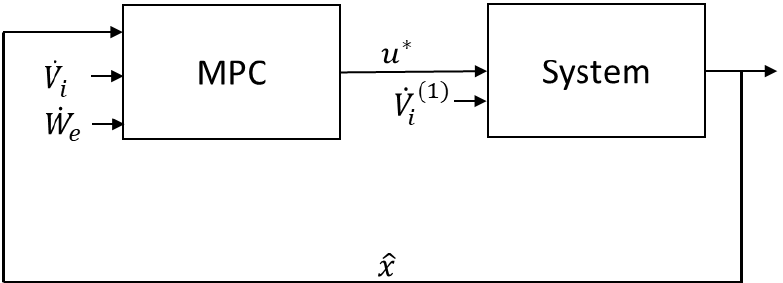
Figure 5. A block diagram of the closed of